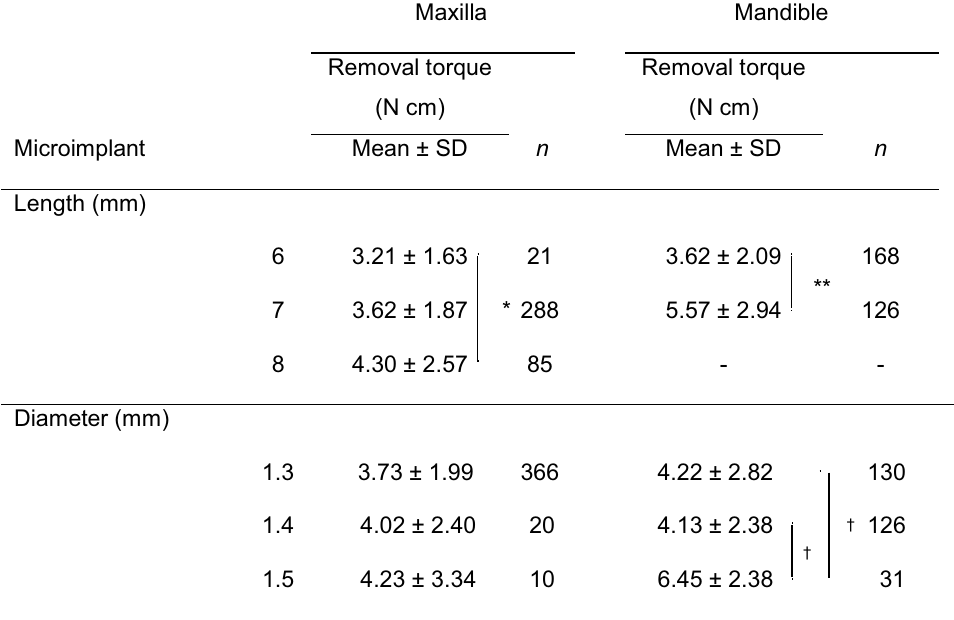
Table 4 Comparison of removal torque values between microimplants with various lengths and diameters Maxilla